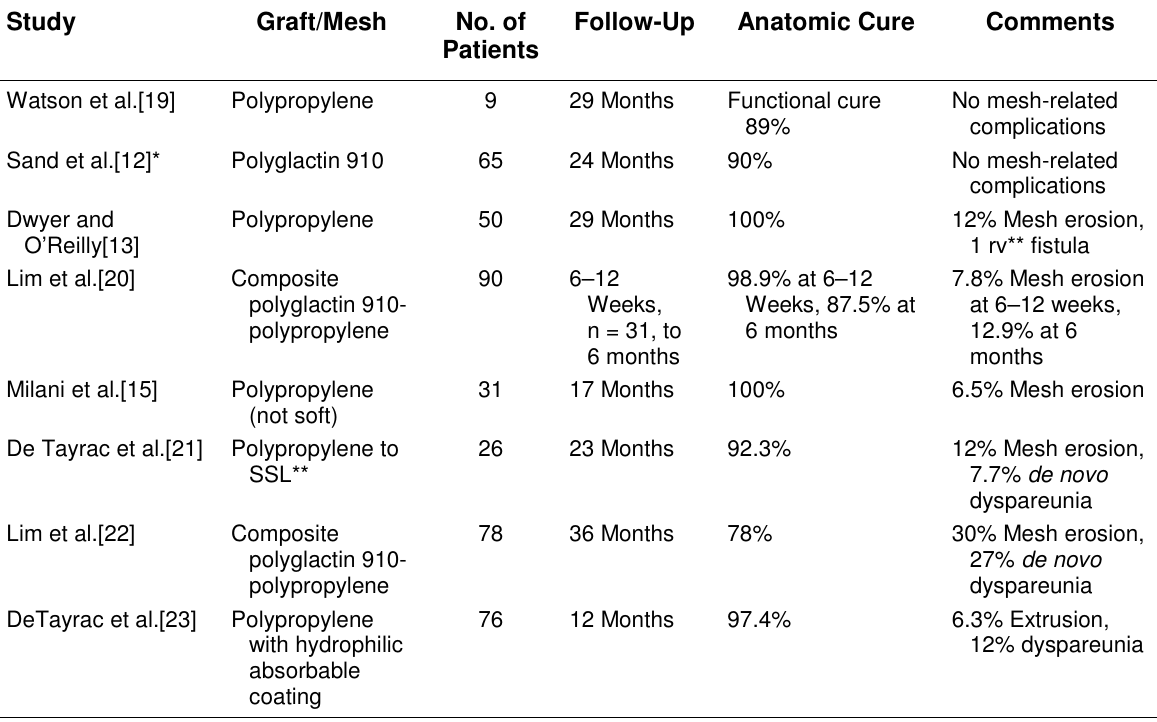
Posterior Prolapse Surgery (Synthetic